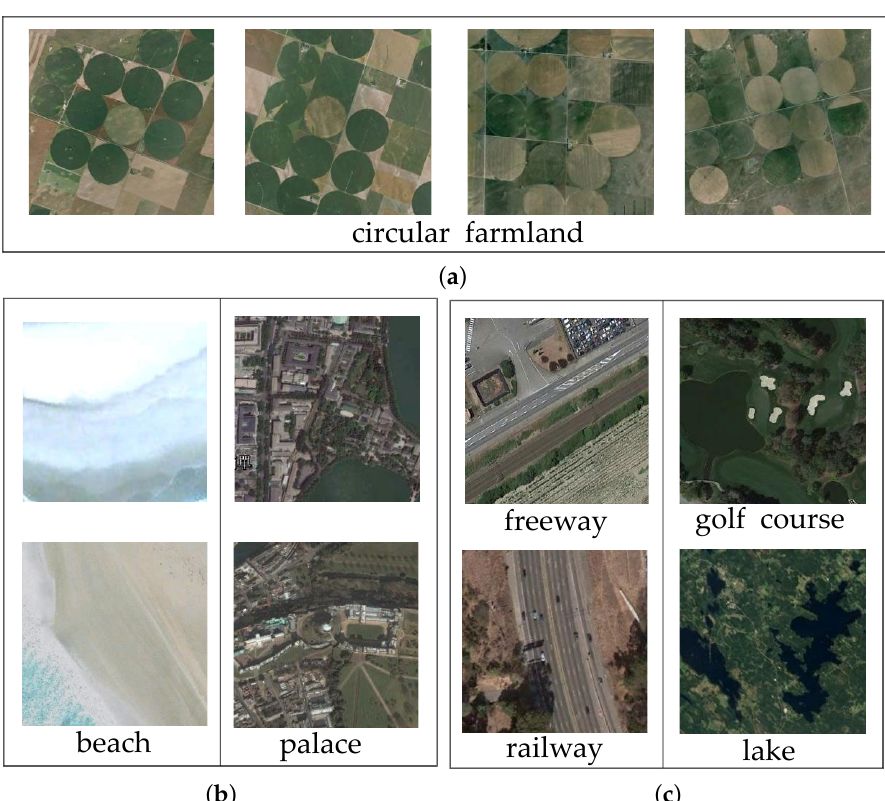
Figure 1. Images collected from NWPU-RESISC45 dataset. Remote sensing images in ( a ) reflect intra-class consistency of these images, which are well-suited to few-shot classification; remote sensing images in ( b ) show large intraclass variances; and images in ( c ) present high similarities between